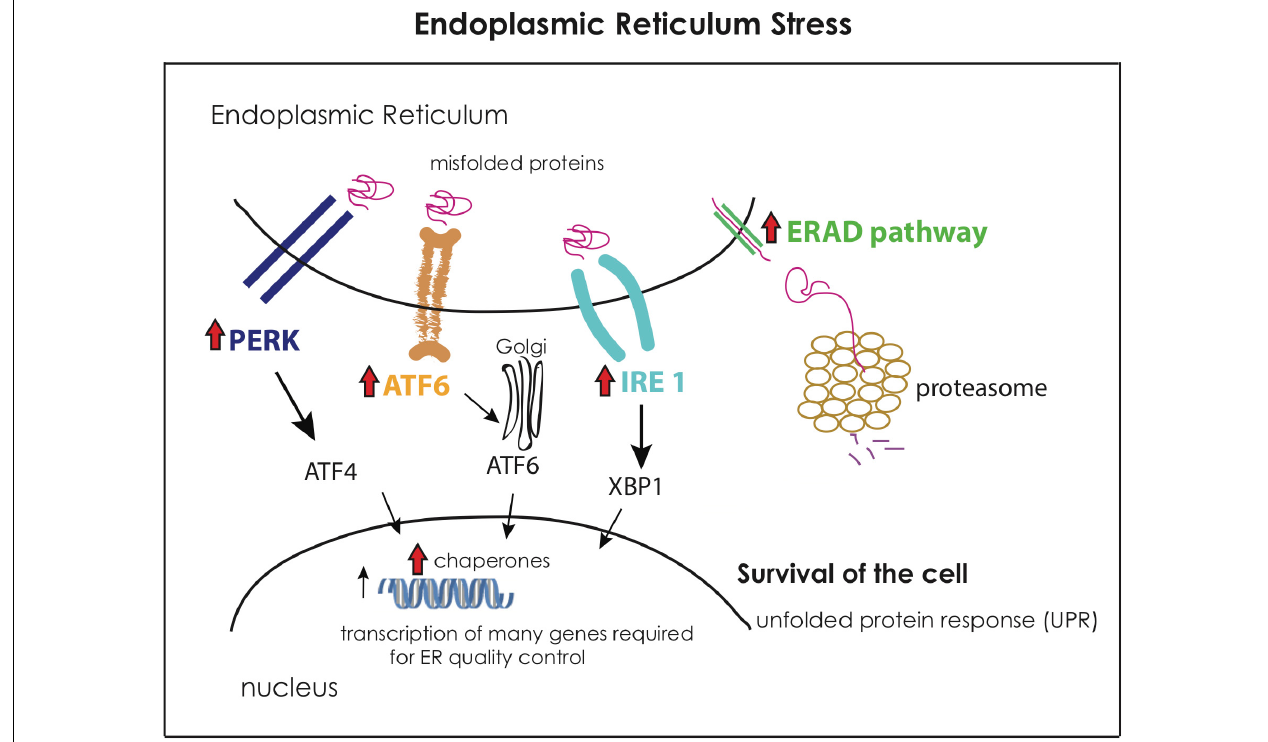
FIGURE 6 | Representation of the molecular activation of the Endoplasmic Reticulum Stress (ER stress) based on theoretical data and the activated genes in the Long-term Heat Shock (LHS) condition compared to the control Cb. The red arrow indicates the overexpression of this gene or functional category in LHS when compared to Cb. The figure is adapted from Kadowaki and Nishitoh (2013).